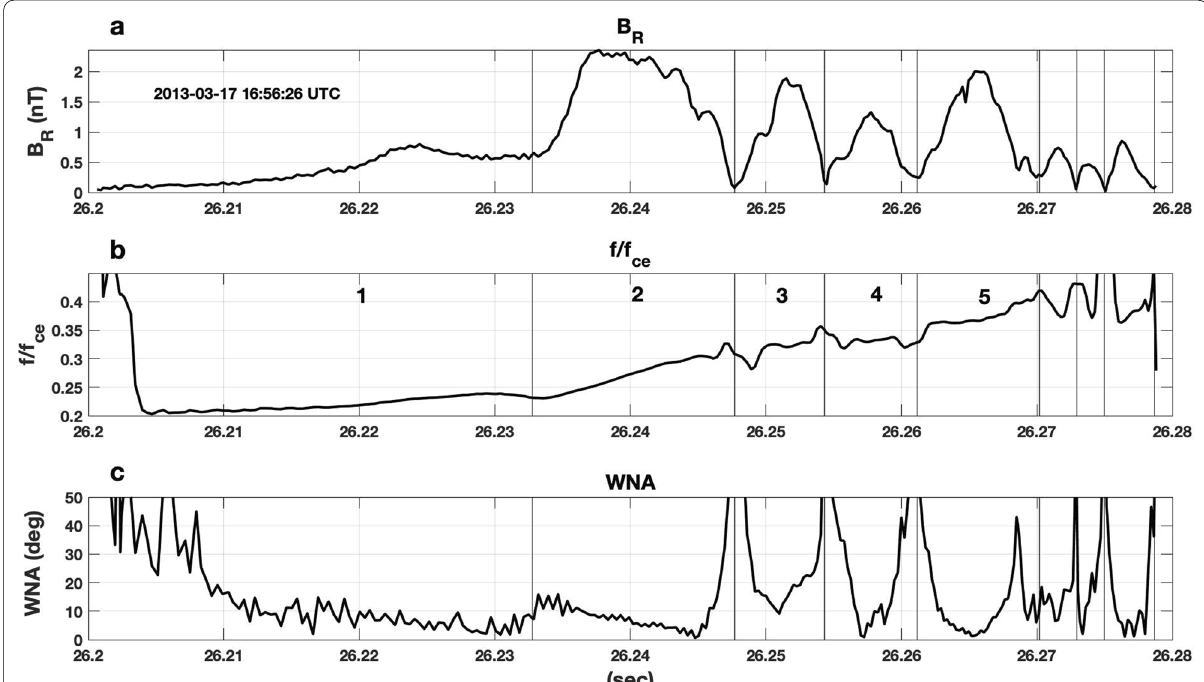
frequency across their temporal extent while a step-like frequency plateau characterizes the shorter subpackets (3 and